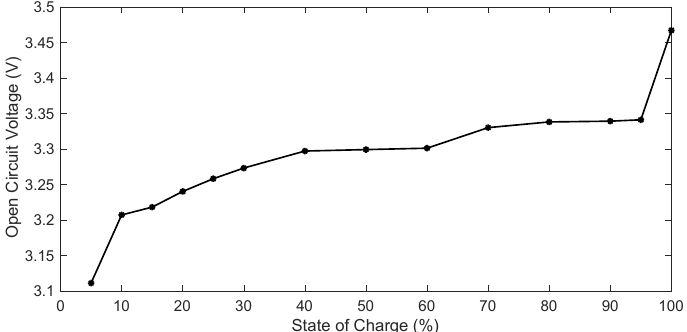
Figure 6. Battery cell open circuit voltage dependence on state of charge.